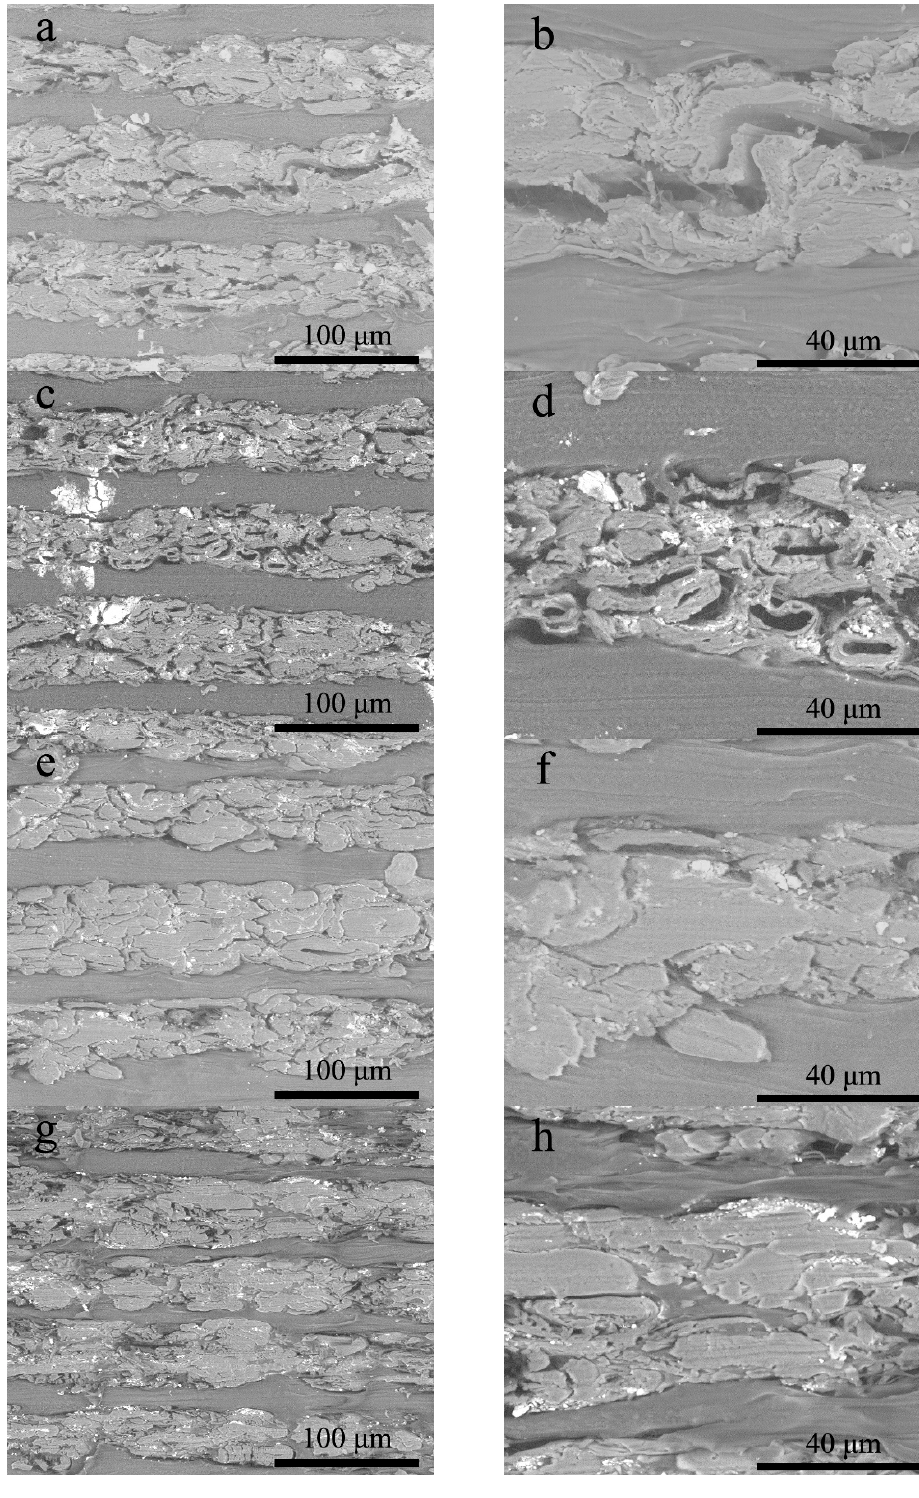
Figure 8. Morphological images of the composite cross sections at different hot pressing time. ( a , b ) 20 min; ( c , d ) 30 min; ( e , f ) 40 min; ( g , h ) 50 min.